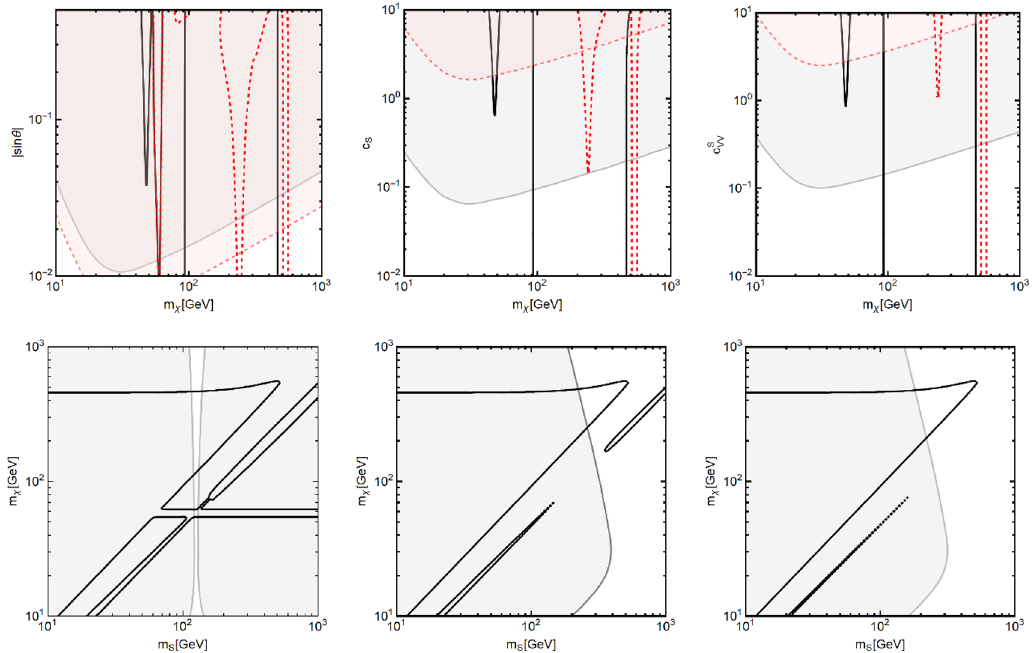
Figure 2 . Isocontours of correct relic abundance for the mixing (left), Yukawa (center), and gauge (right) portals for y S = 1. The upper panels display the m (cid:31) (cid:0) coupling plane for m S = 100 GeV (black, solid) and m S = 500 GeV (red, dashed). In the case of the mixing portal j sin (cid:18) j has been put on the y-axis instead. The lower panels show the m S (cid:0) m (cid:31) plane for sin (cid:18) = 0 : 1, c S = 1, c S for the mixing, Yukawa and gauge portals, respectively. DD limits from XENON1T are given as light red (gray) shaded regions for the case of a light (heavy) mediator S . In all cases we have set (cid:3) = 3 TeV.